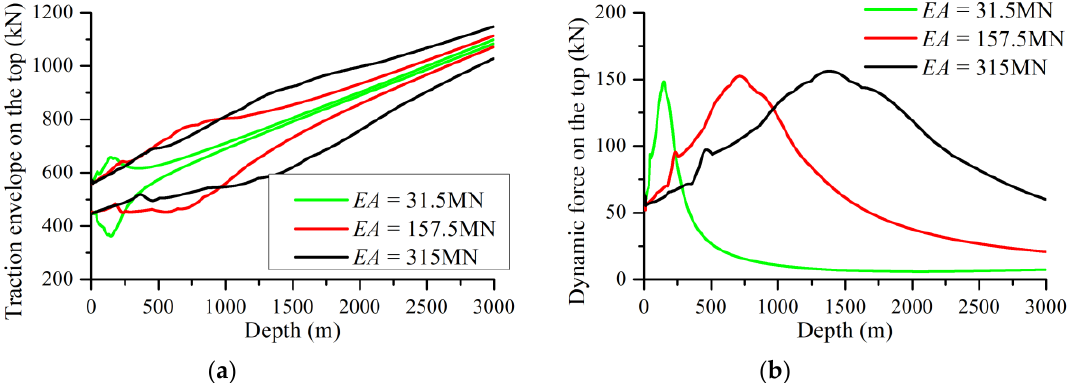
Figure 14. Influence of the cable stiffness on the traction on the top of the cable: ( a ) traction envelope, ( b ) dynamic force.